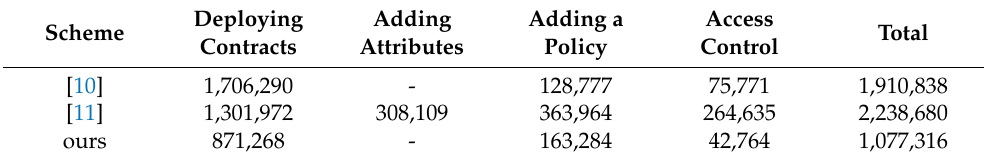
Table 4. Comparison of gas costs for main